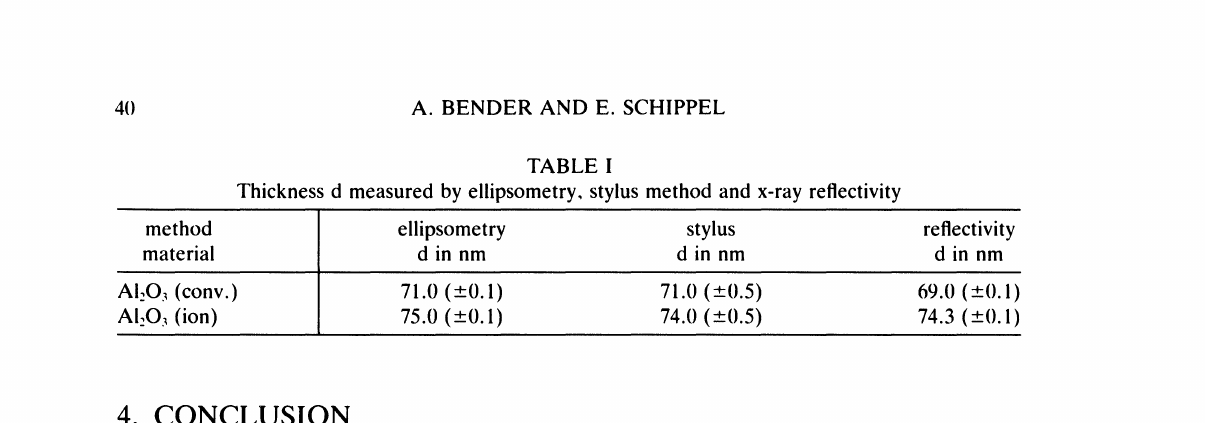
Thickness d measured by ellipsometry, stylus method and x-ray reflectivity method material A120.